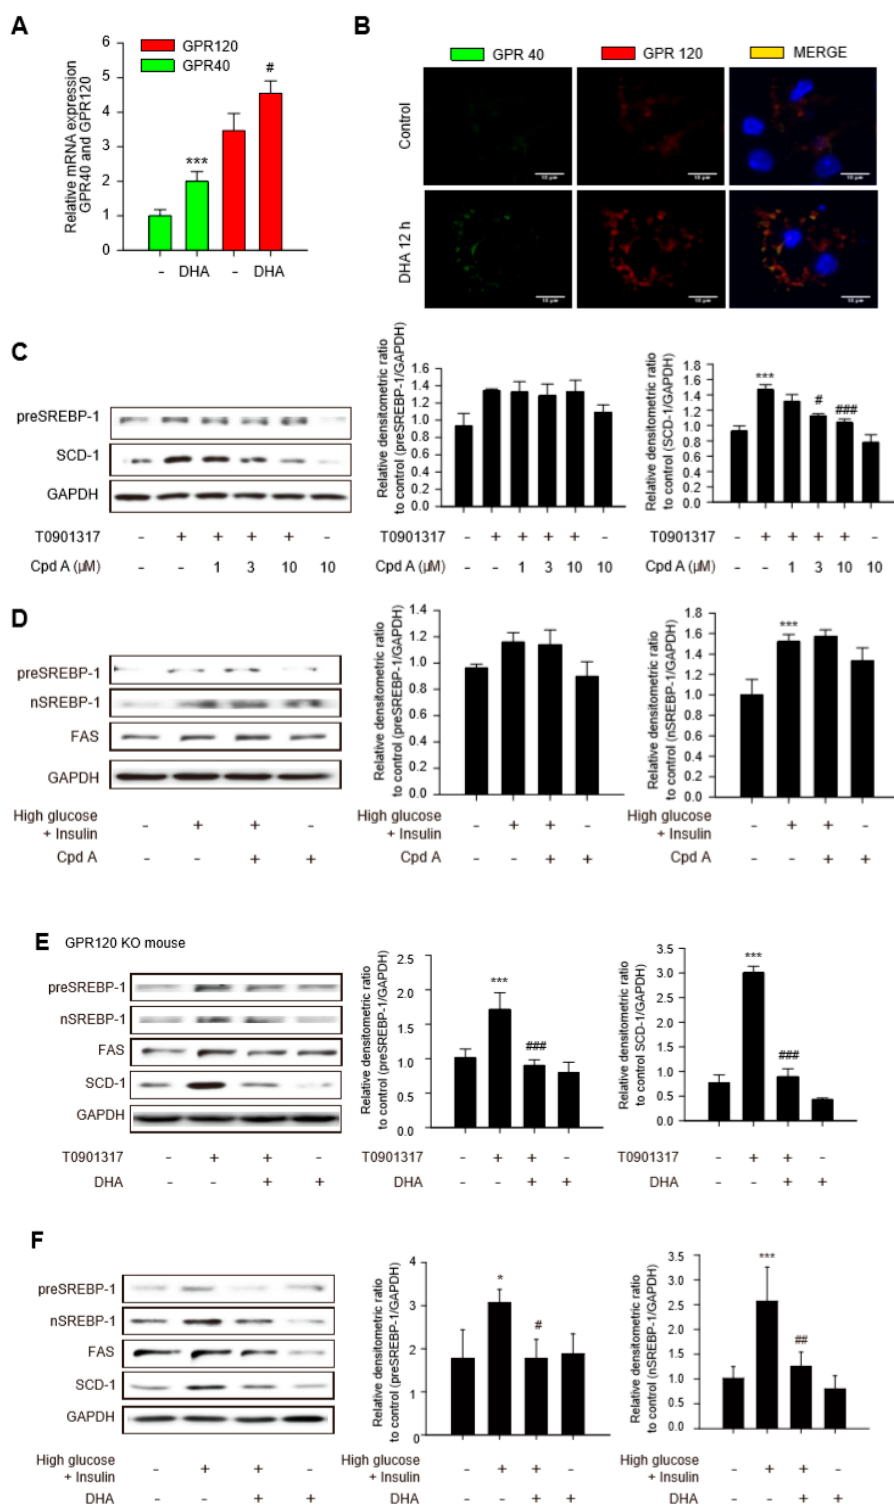
Figure 3. Role of GPR120 in expression of lipogenesis enzymes in hepatocytes. ( A ) Relative mRNA expressions of GPR40 and GPR120 levels were determined by real-time qPCR analyses in mouse primary hepatocytes. Data represent means ± SD ( n = 3). *** p < 0.005 compared with the GPR40 level of the control group; # p < 0.05 compared with the GPR120 level of the control